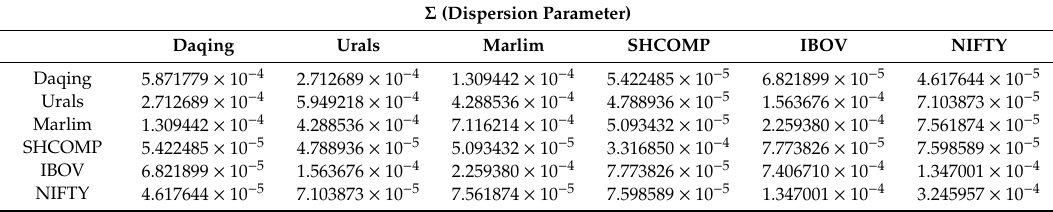
Table A3. MNIG Dispersion parameter Σ for Vector 1: Daqing, Urals, Marlim, SHCOMP, IBOV, NIFTY.